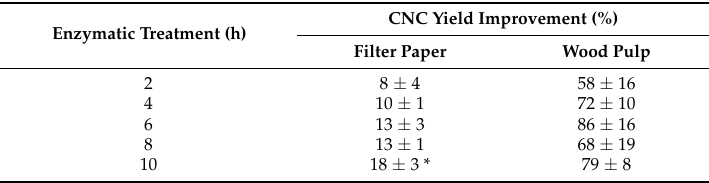
Table 2. Improvement in CNC yield (%) from acid hydrolysis of cellulase cocktail-treated filter paper and wood pulp relative to the untreated